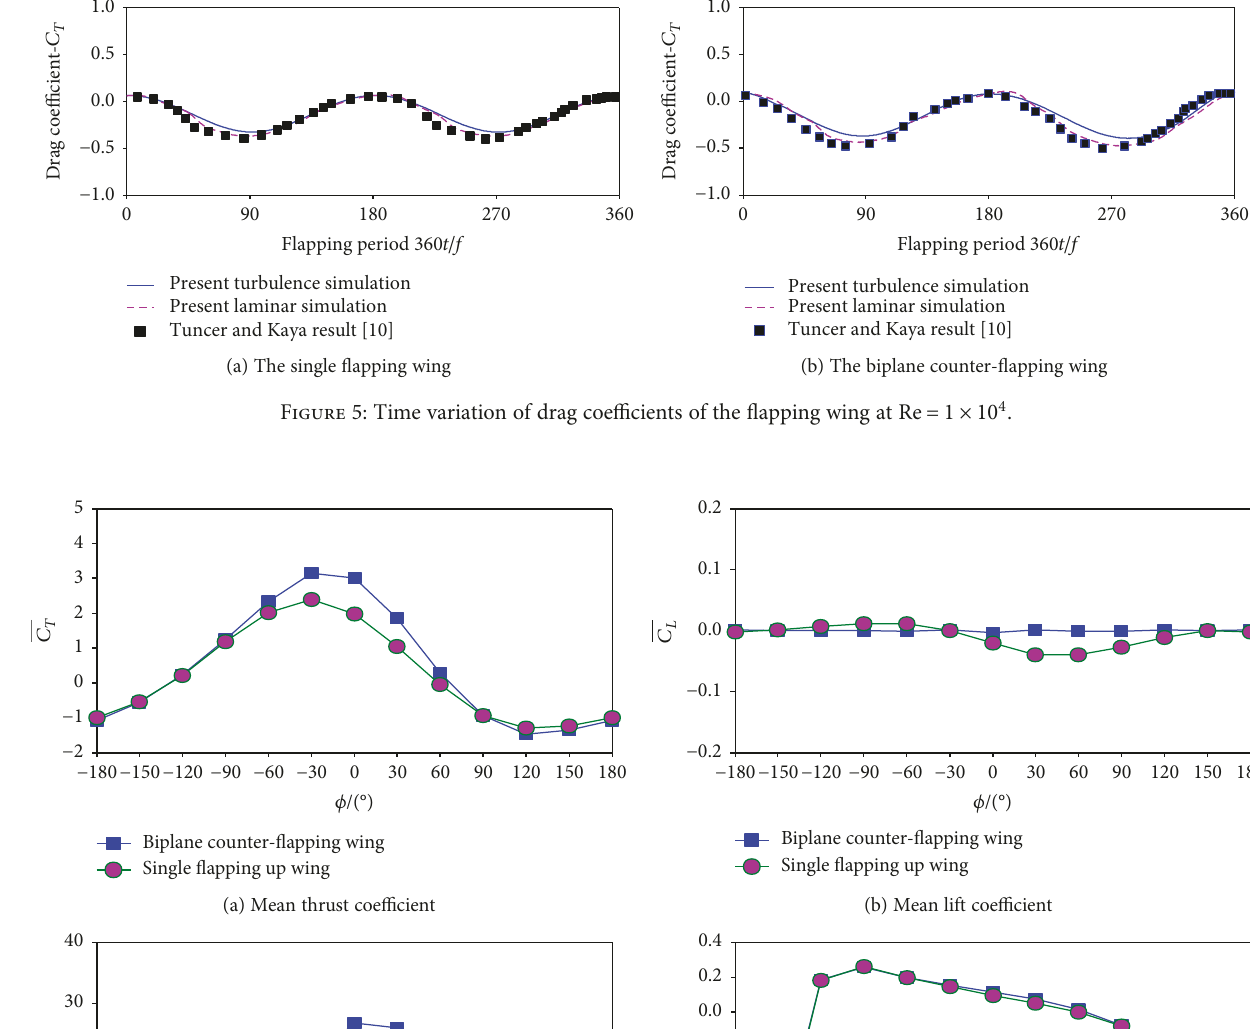
Present turbulence simulation Present laminar simulation